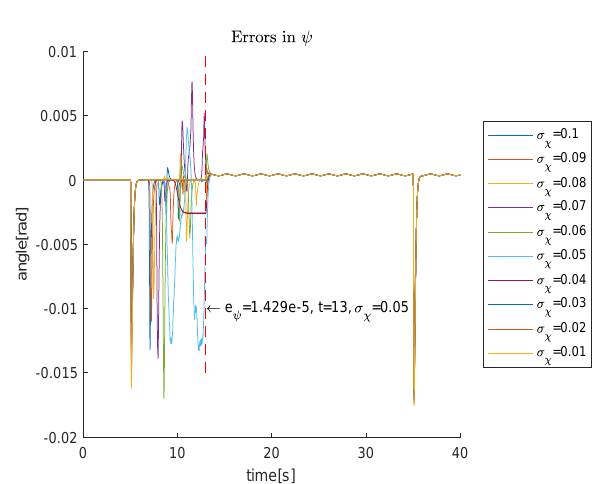
Figure 22. Errors in ψ with distinct σ χ